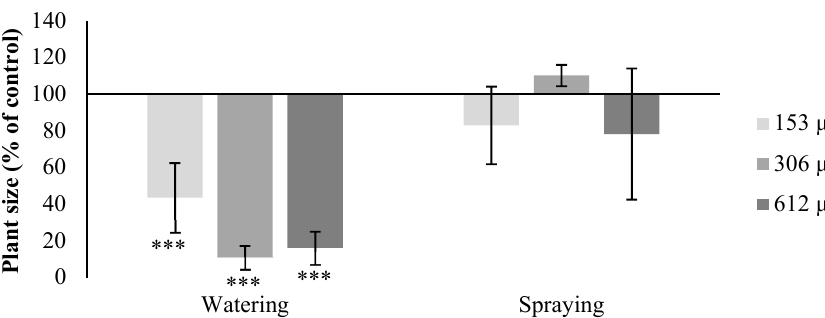
Figure 4. Plant size in the percentage with respect to the control of A. thaliana watered and sprayed with different concentrations of norharmane (0, 153, 306 and 612 µM) for 21 days. Asterisks indicate significant differences from controls (*** p ≤ 0.001).